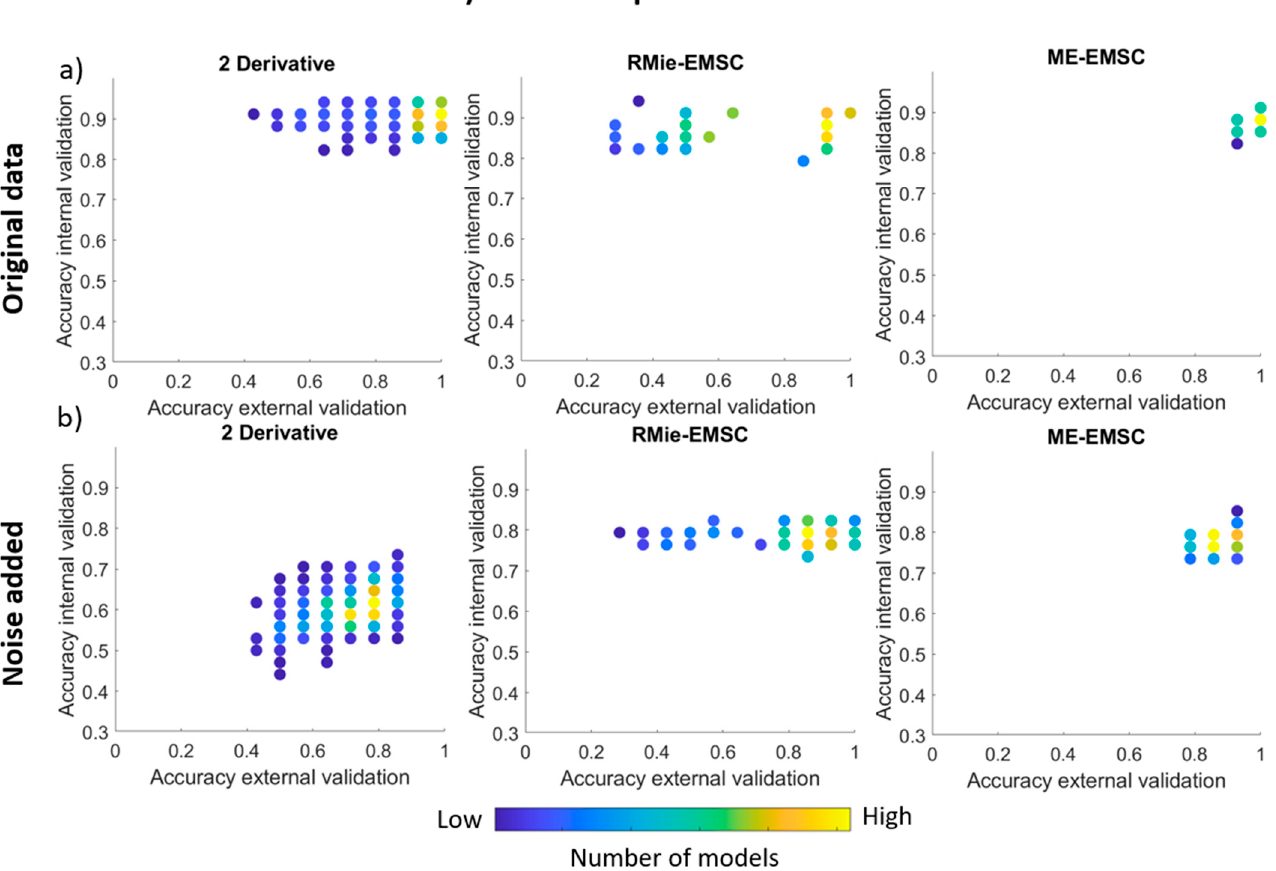
Figure 4. Internal and external accuracy values comparison for the best LVs for: ( a ) original data and ( b ) noise added data, for baseline correction methods: DER, RMie-EMSC, and ME-EMSC.